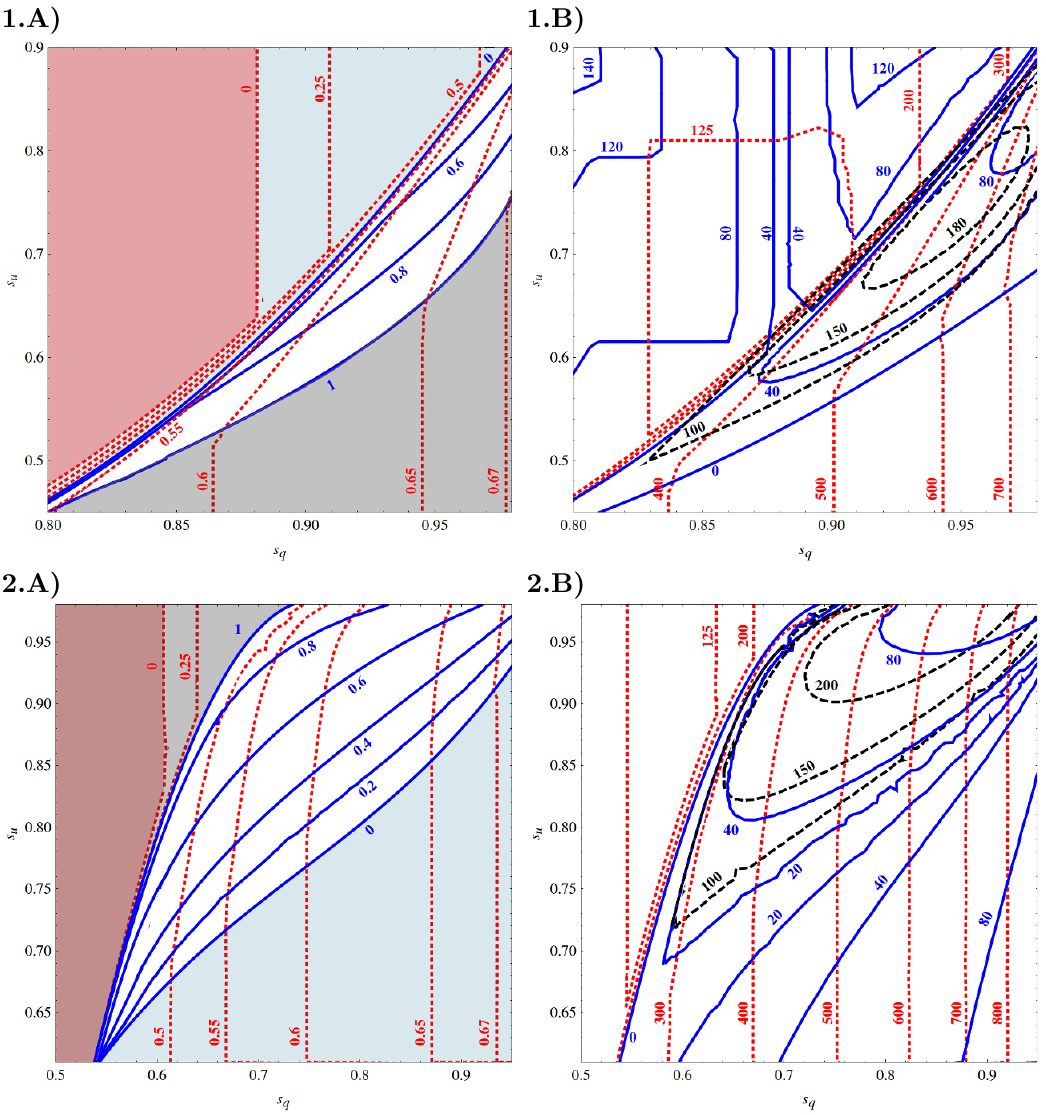
Figure 1 . Contour plots for the values of (cid:15) 5 and (cid:15) 6 at the minimum of the potential (red dotted and blue solid lines respectively in plots labeled with an A) and for the masses of the Higgs, the new scalar h 6 and the top quark (red dotted, blue solid and black dashed lines respectively in plots labeled B) as functions of the mixings s q and s u for two di(cid:11)erent sets of parameters, labeled with 1 and 2, as described in the text.. In the A plots, the gray region corresponds to (cid:15) 6 = 1, the light blue region to (cid:15) 6 = 0 and the red region to (cid:15) 5 = 0. All masses are expressed in